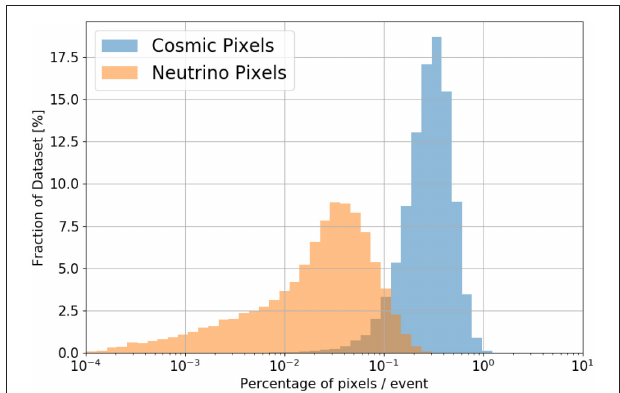
FIGURE 7 | Distribution of pixel occupancies, by label, in this dataset. In general, the cosmic-labeled pixels are < 1% of pixels and the neutrino-labeled pixels are <